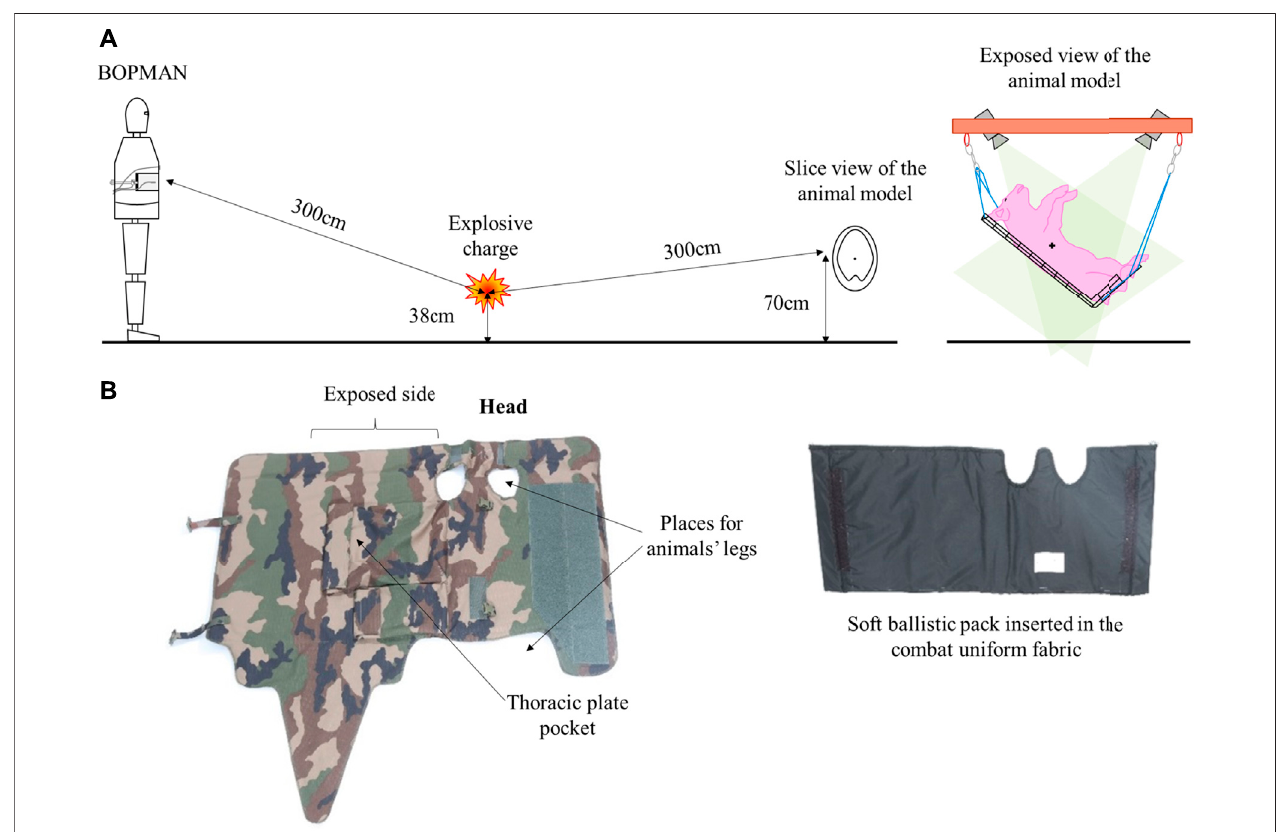
FIGURE 2 | (A) Animal and BOPMAN position during a blast exposure (cross on the swine gives the position of the accelerometer); (B) Illustration of the animal thoracic protection.